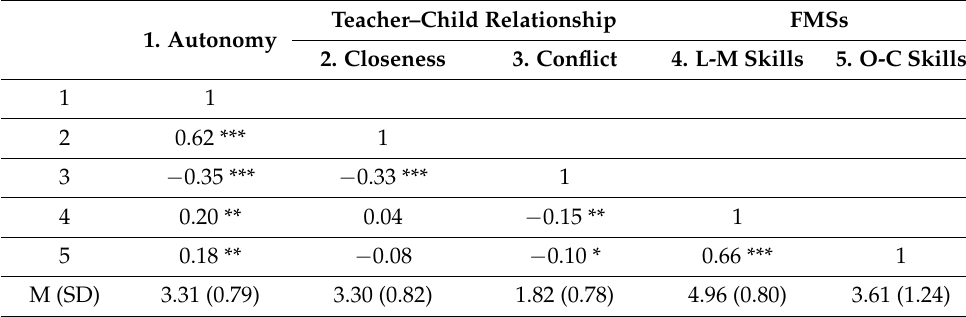
Table 2. Correlation of main variables. 1.